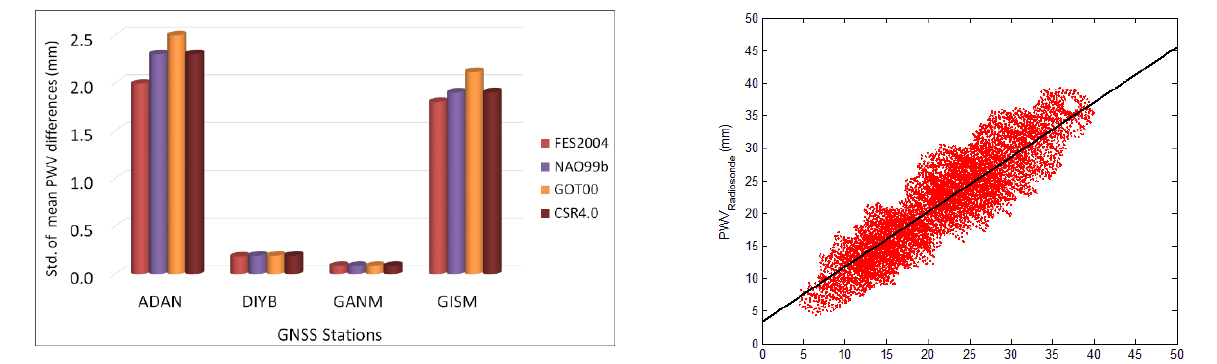
Figure 2. Standard deviation of mean differences between strategies using different Ocean Tide models and without OTL strategy.